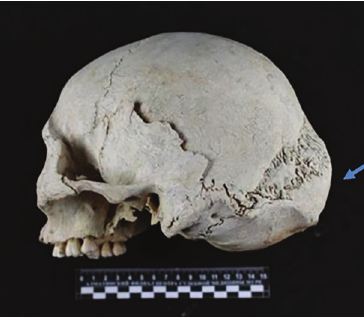
The interparietal suture is deformed and deviates to the left in its apical and bregmatic parts (Figure 3). The occipital suture is represented by significantly overgrown teeth, has a width of up to 35 mm (Figure 4).